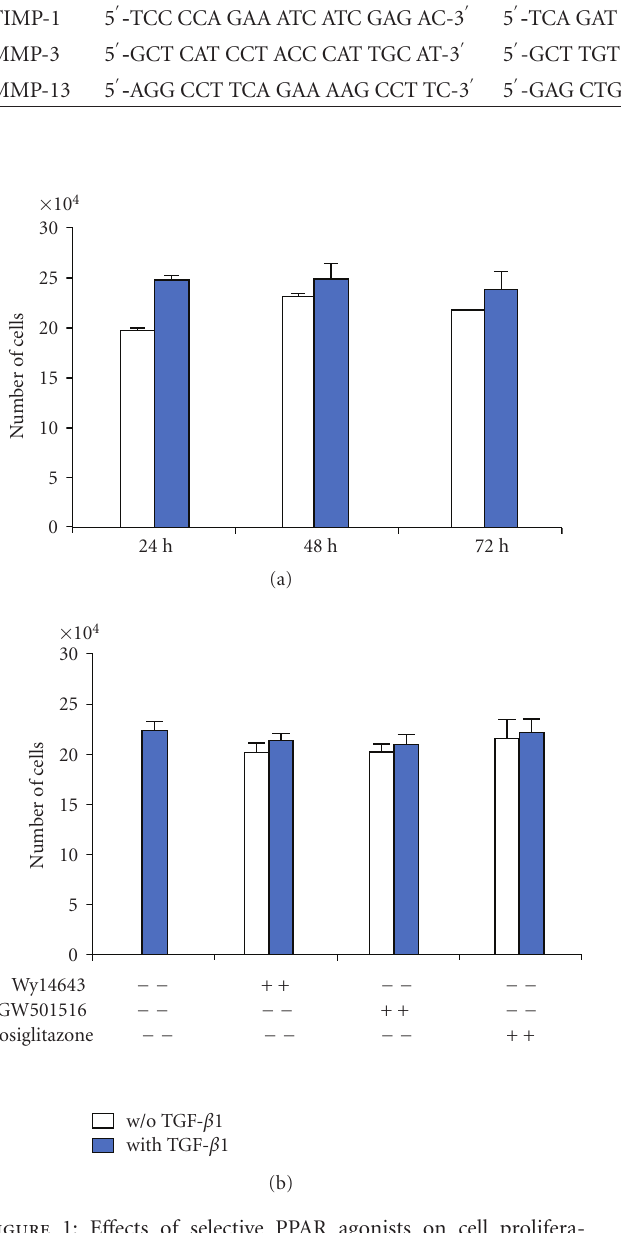
Figure 1: E ff ects of selective PPAR agonists on cell prolifera- tion in rat chondrocytes stimulated with TGF- β 1 . Chondrocytes, embedded in alginate beads (5.10 4 cells per bead), were exposed to Wy14643 (100 μ M), GW501516 (100nM), or rosiglitazone (10 μ M) for 2h before stimulation with TGF- β 1 (10ng/mL), in the presence or absence of PPAR agonists, for 72h. Levels of total DNA were measured by Hoechst assay. (a) Time course e ff ect of TGF- β 1; (b) e ff ect of PPAR agonists in presence of TGF- β 1. Data are expressed as mean ±